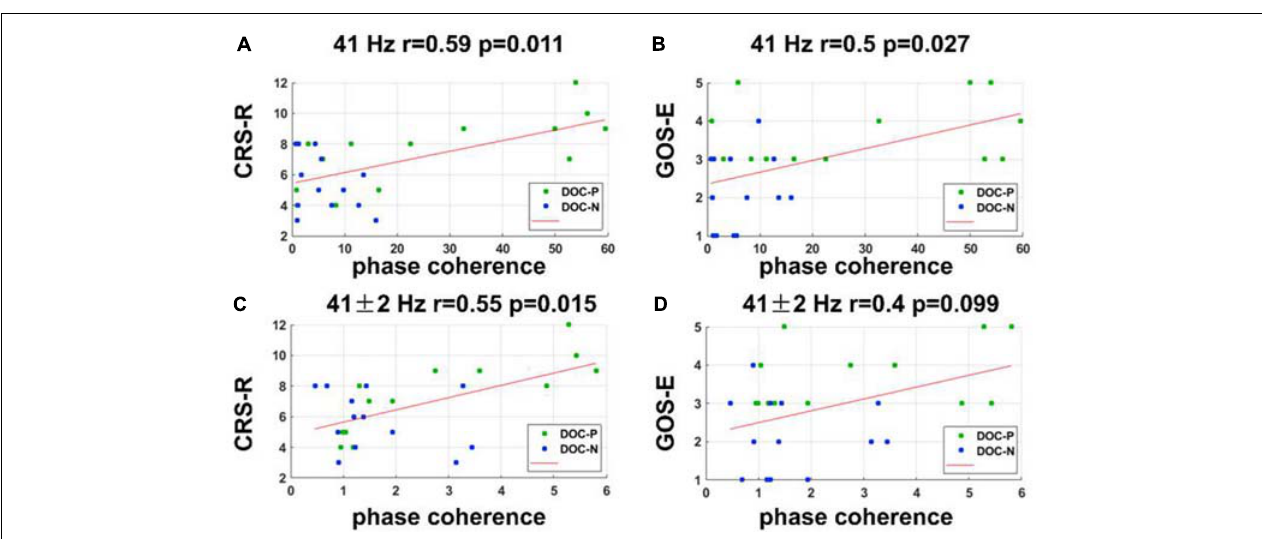
FIGURE 4 | Correlations between neural synchronization at 41, 41 ± 2 Hz, and clinical evaluations. (A,B) Correlations between the phase coherence at 41 Hz and CRS-R, and GOS-E scores. Phase coherence at 41 Hz was independently correlated with CRS-R and GOS-E scores ( r = 0.59, P = 0.011, FDR corrected; r = 0.5, P = 0.027, FDR corrected). (C,D) Correlations between the phase coherence at 41 ± 2 Hz and CRS-R, and GOS-E scores. Phase coherence at 41 ± 2 Hz was correlated with CRS-R score ( r = 0.55, P = 0.015, FDR